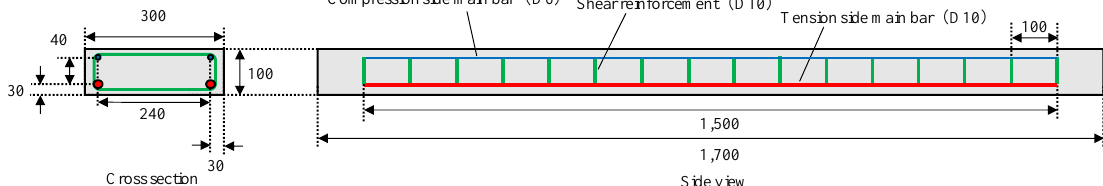
Figure 4. Dimensions of unreinforced specimen.